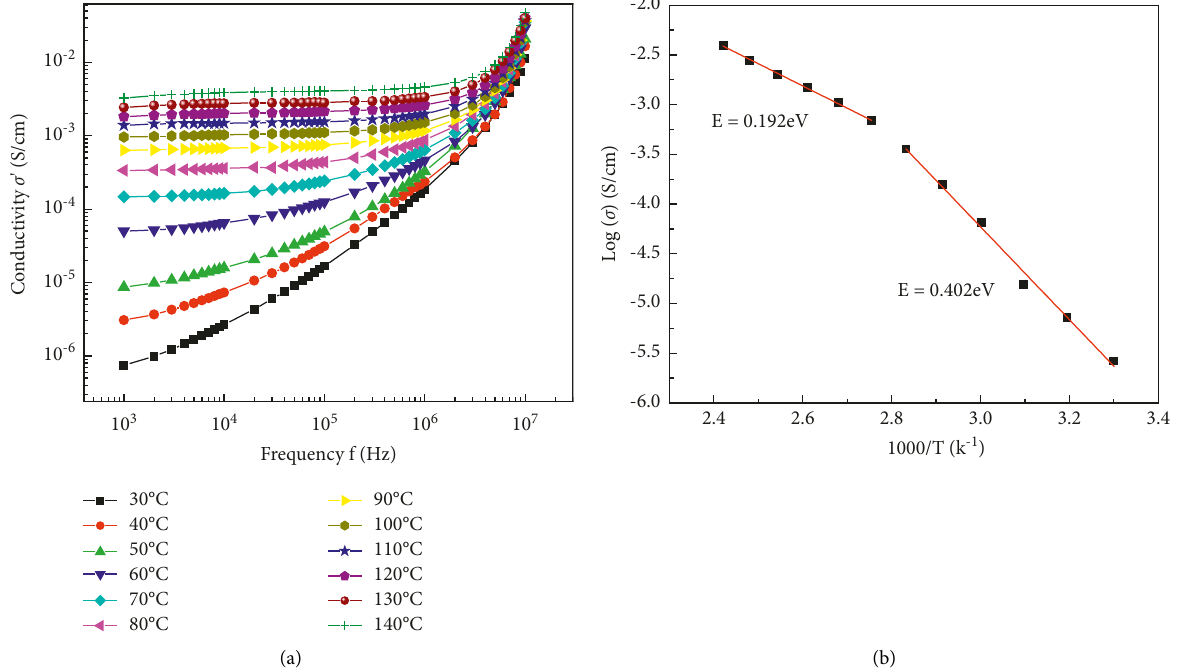
Figure 12: (a) Frequency dependence of AC conductivity at different temperatures and (b) log ( σ ) versus 1000/T, for 0.5wt.% FeCl PVP electrolyte blend.